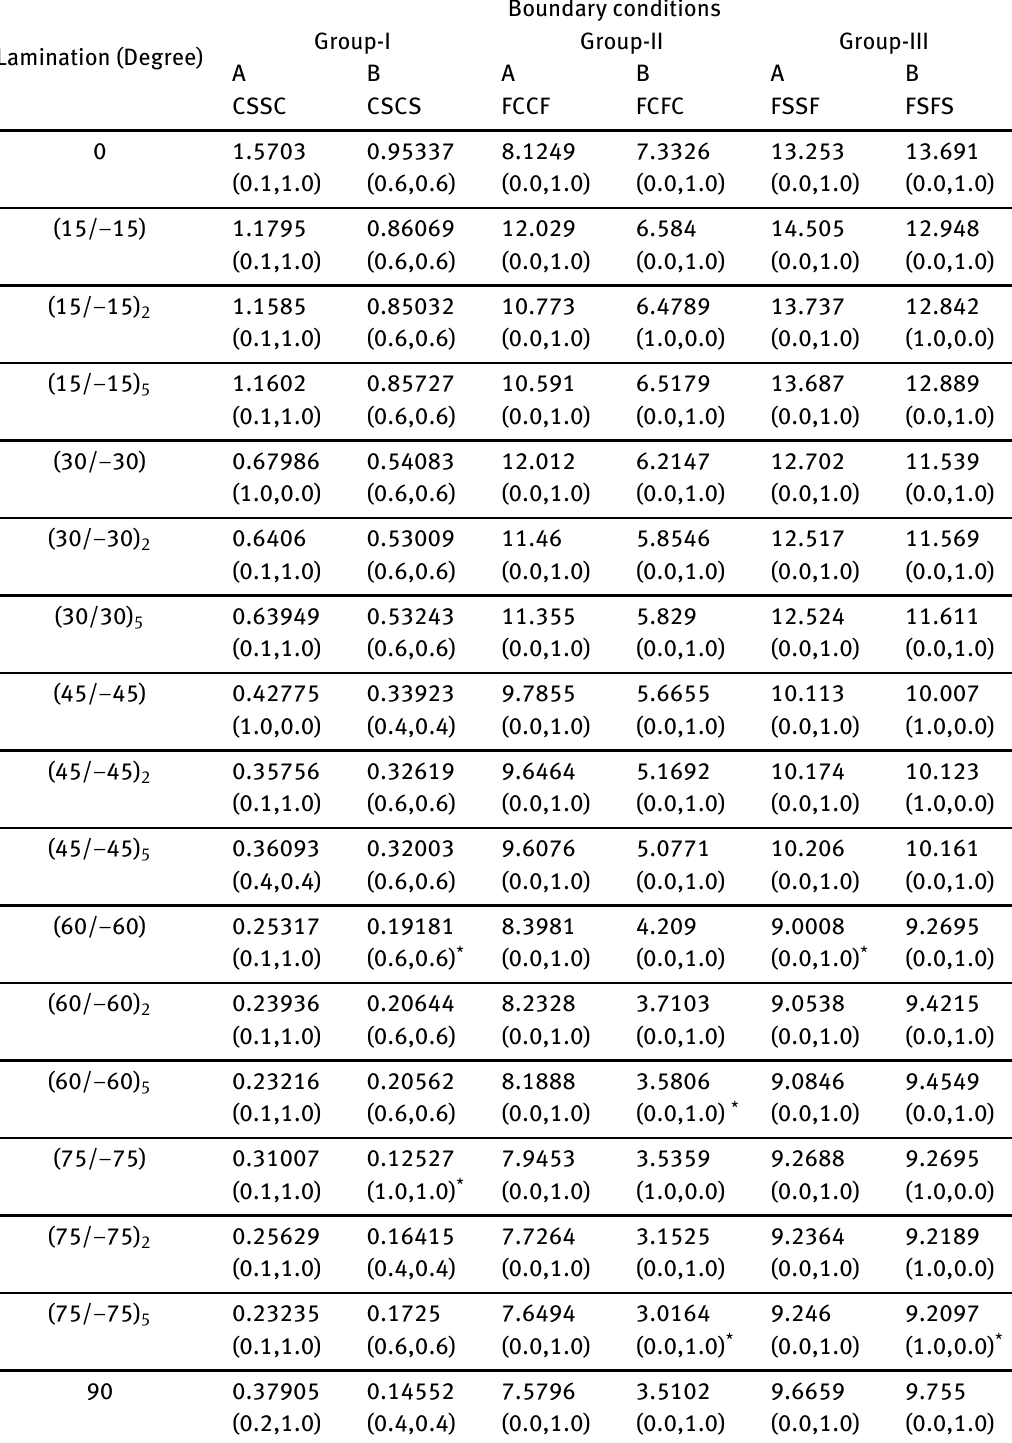
Table 6: Values of maximum non-dimensional tensile in-plane forces (+ N y ) for different antisymmetric angle ply lami- nation and boundary conditions of stiffened composite hypar shell with cutout